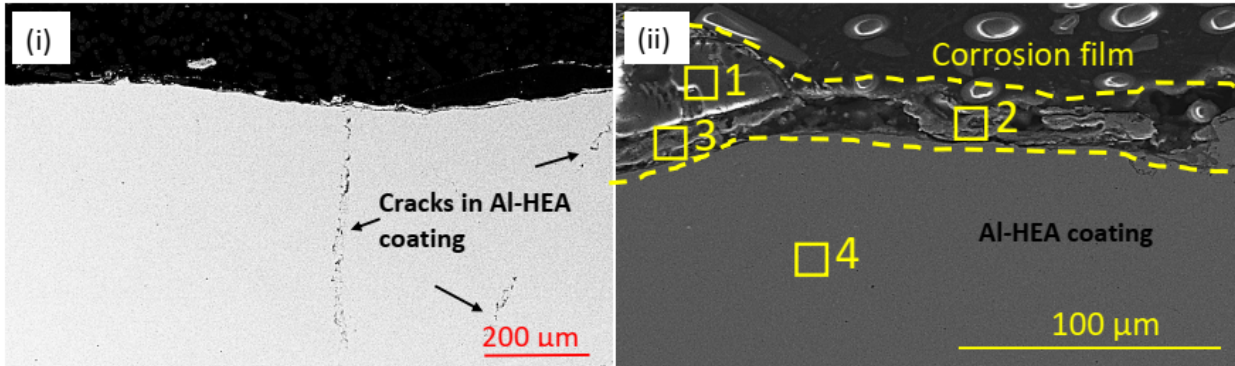
Figure 8. ( i ) Manufacturing cracks and ( ii ) oxide-rich corrosion products (and some sulfides) on the surface on the exposed in the Al-HEA coating in sample Al-HEA-304L in the wellhead test. Table 4. Elemental EDX analysis from locations in Figure 8ii.